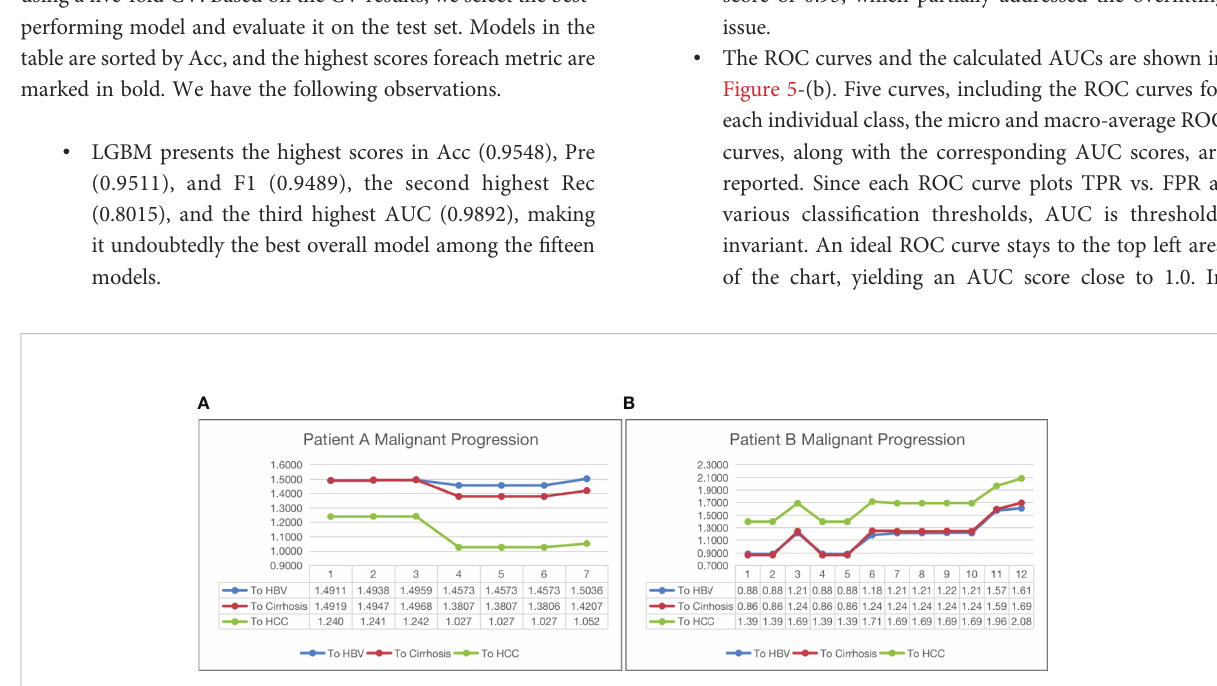
FIGURE 4 Malignant progression analysis for patient A (sub fi gure (A) ) and patient B (sub fi gure (B)